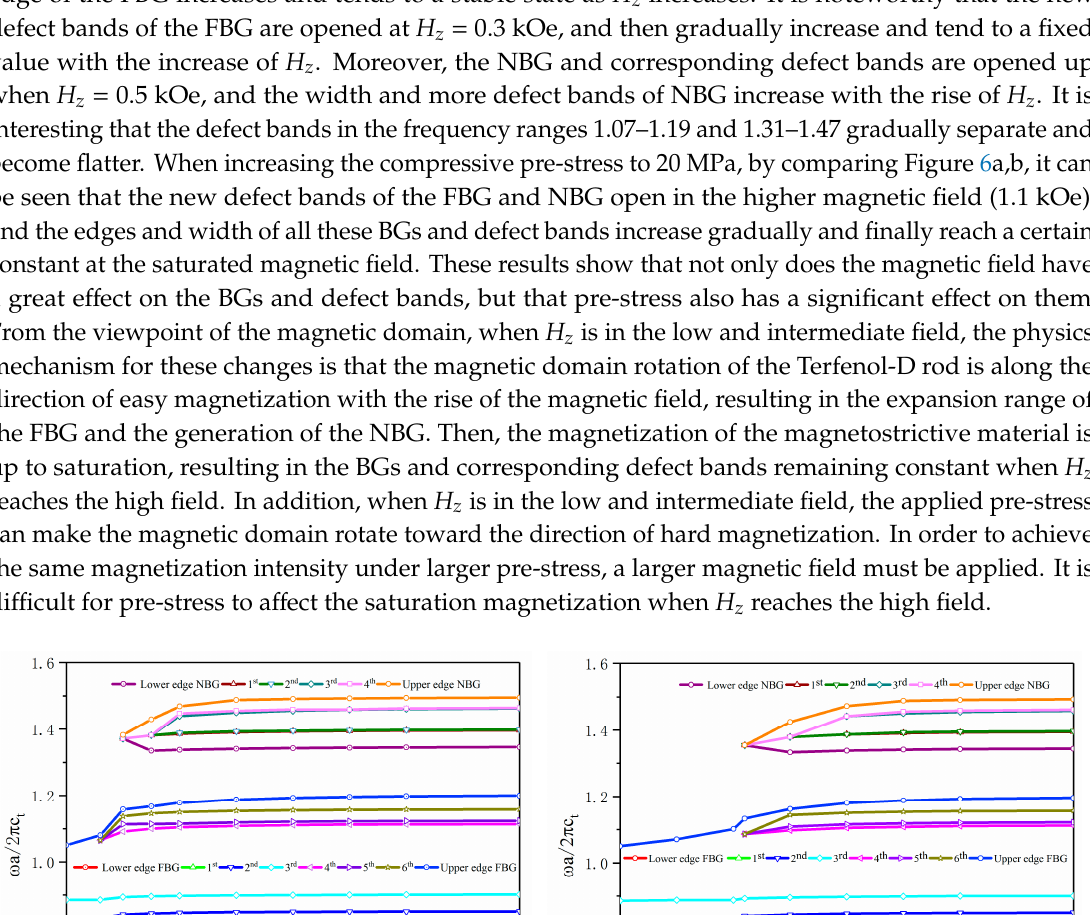
Figure 6. The variation in defect band frequency ( XY modes) as a function of magnetic field. ( a ) σ z = 0 MPa and ( b ) σ z = − 20 MPa. Legend: NBG, new band gap; FBG, first band